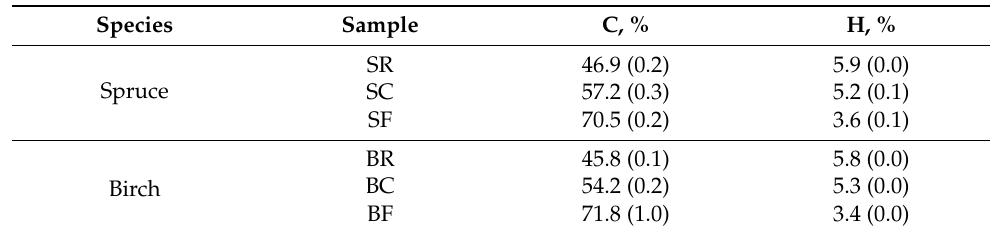
Table 2. Elemental composition of unmodified and modified spruce and birch surfaces. Standard deviation (n = 3) in parenthesis.